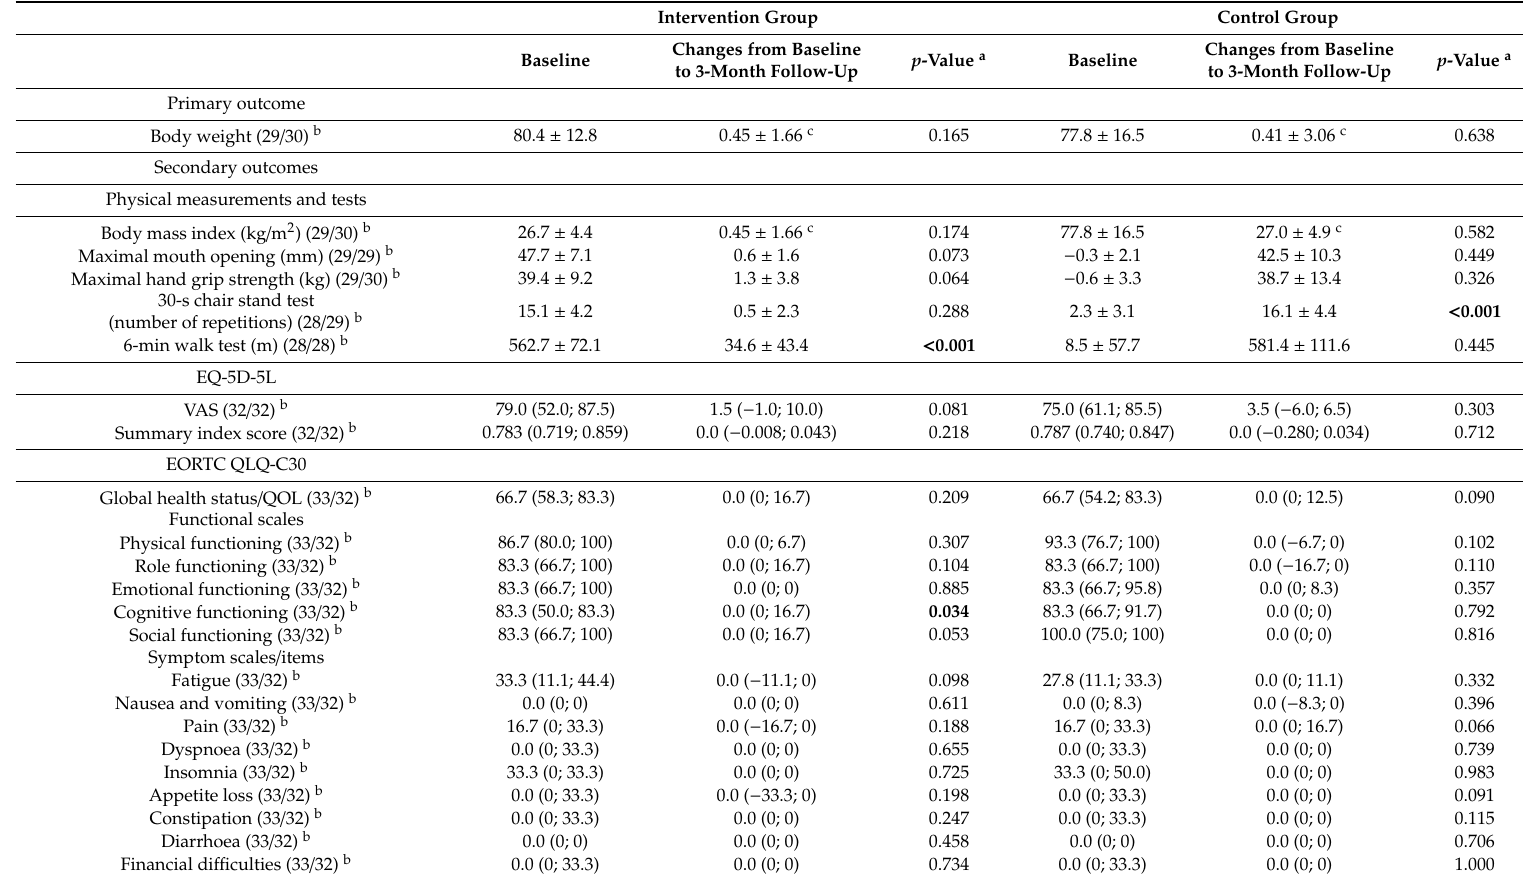
Table A2. Tests of within group di ff erences in body weight, physical function, health-related quality of life, and symptoms of anxiety and depression from baseline to 3-month